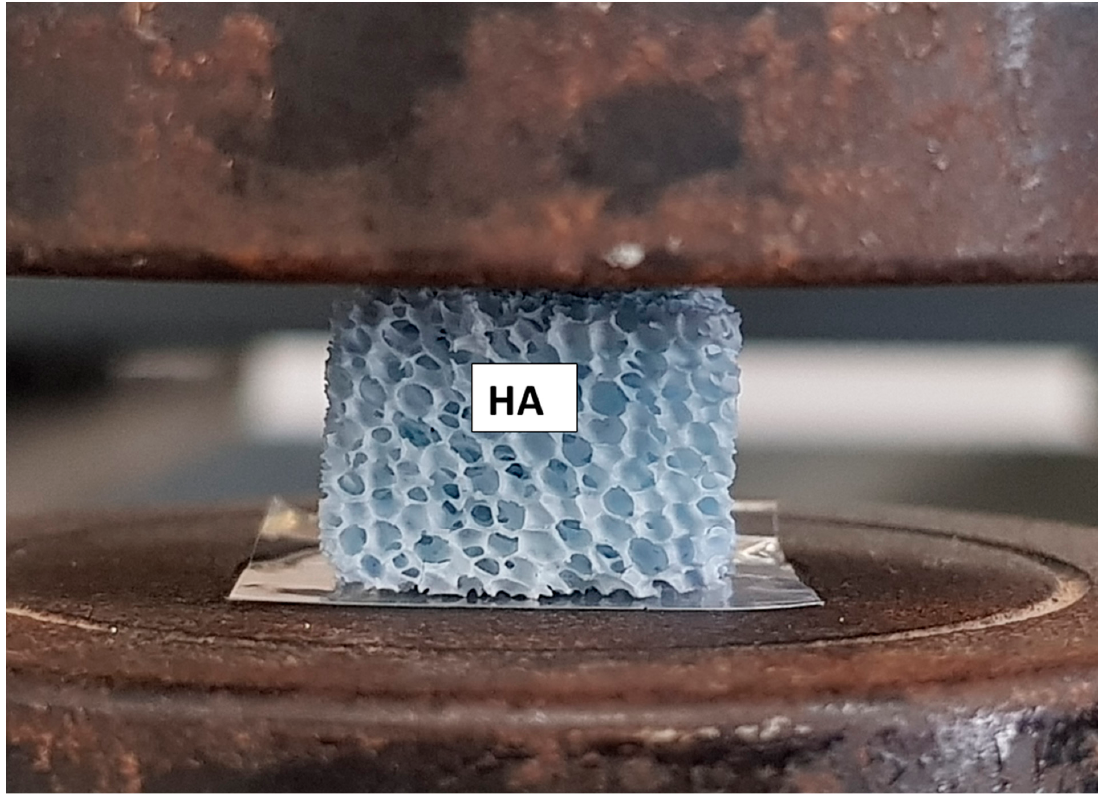
Figure 1. The HA scaffold during the mechanical properties test (HA).